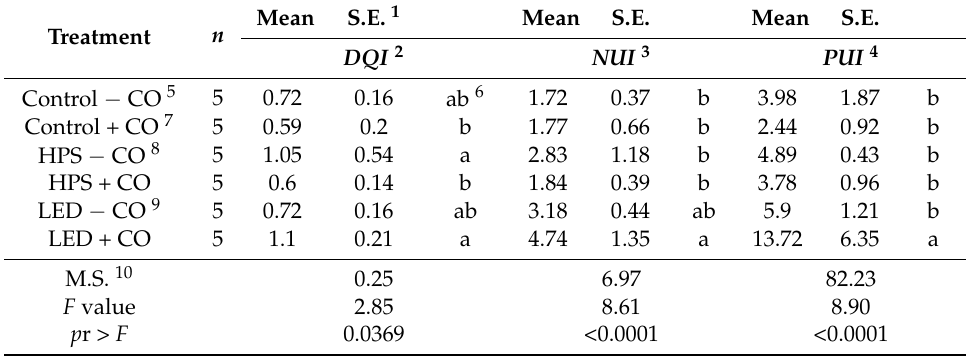
Table 4. The interactive effects of lighting spectra and chitosan oligosaccharide addition on evaluated seedling quality and nutrient utilization of Fragrant rosewood ( D. odorifera )